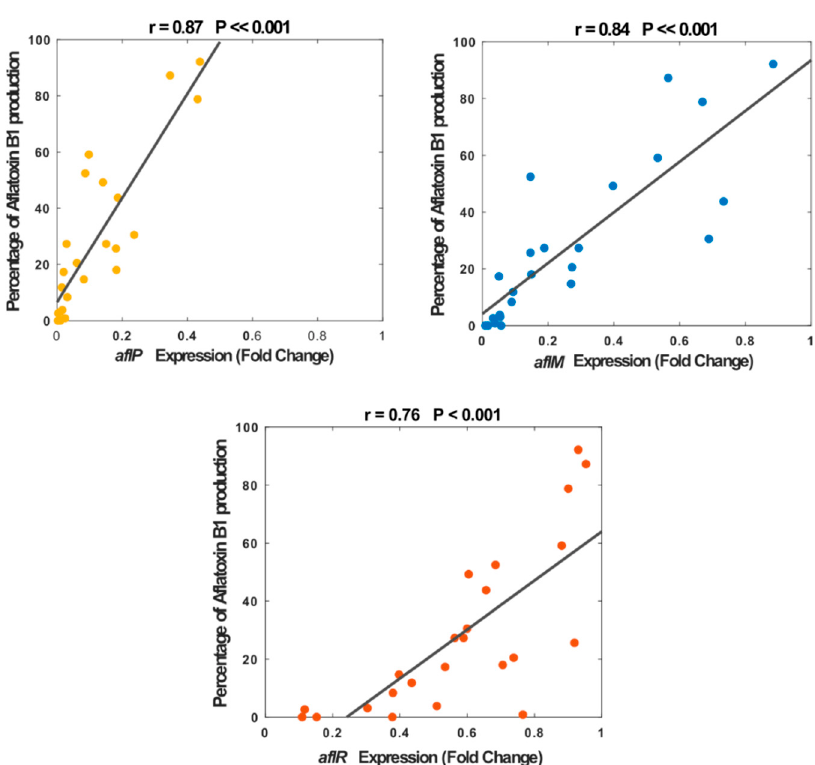
Figure 5. Relationship between the aflatoxin B1 production and the fold change of gene expression, for aflM (colored in blue), aflP (colored in yellow), and aflR (colored in orange) genes. Our results showed a significant correlation between the percentage of aflatoxin B1 production and the fold change expression of aflM ( r = 0.84, p << 0.001), aflP ( r = 0.87, p << 0.001), and aflR ( r = 0.76, p < 0.001).